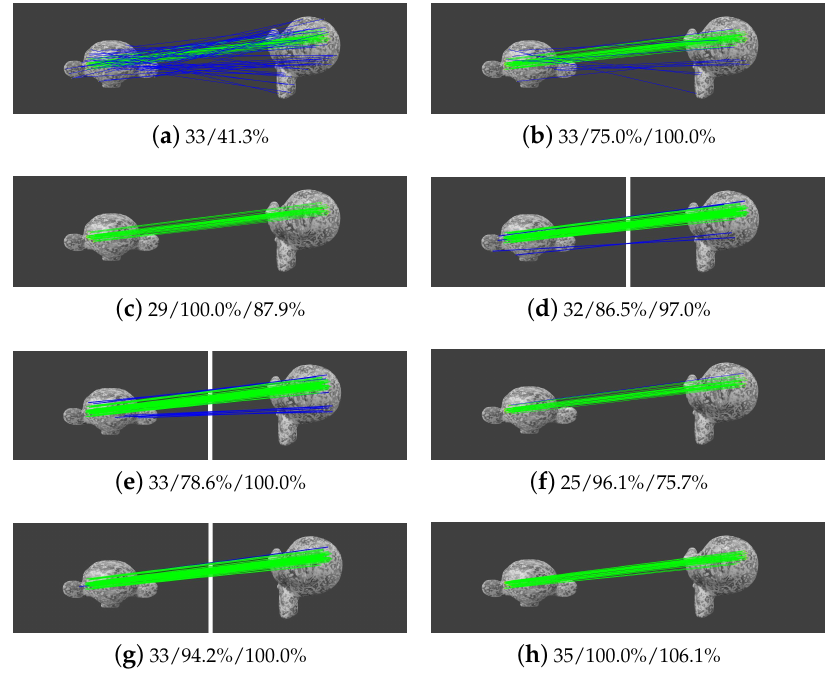
Figure 18. Matching results of image pair 1 in the non-rigid dataset: ( a ) initial matches; ( b )